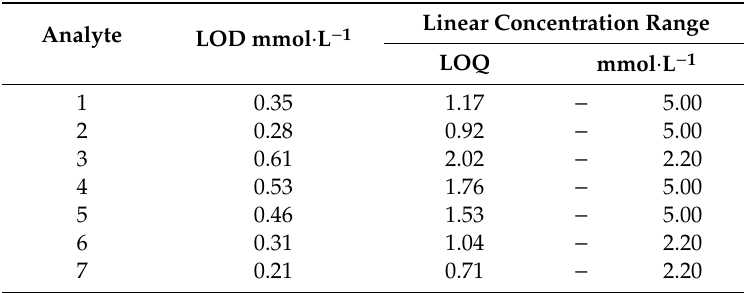
Table 2. LOD and LOQ with a linear concentration range of calibration dependences of individual analytes 1–7 (Figure 2) according to Mandel’s